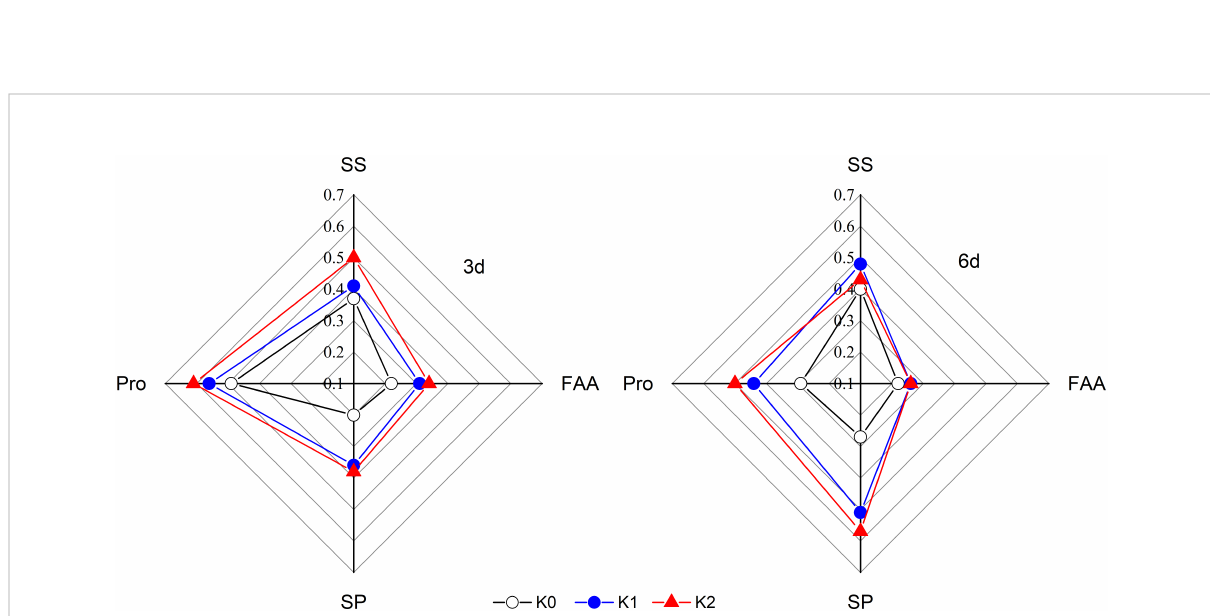
FIGURE 3 Variations of the osmotically active solute concentration in sesame leaf at 3 and 6 days, caused by drought stress, demonstrated by the coef fi cient of stress. K0, K1, and K2 represent K application rates at 0, 60, and 120 kg ha − 1 K 2 O, respectively. SS, Pro, SP, and FAA stand for soluble sugar, proline, soluble protein, and free amino acid contents, respectively.